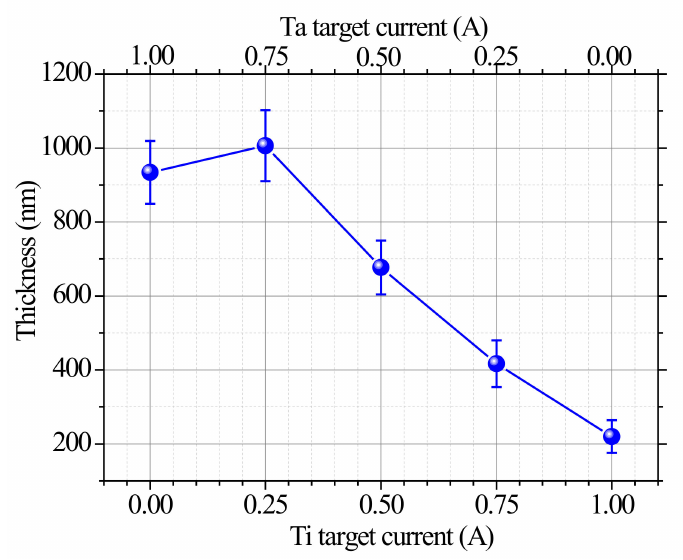
Figure 1. Coating thickness as a function of the Ti and Ta target applied